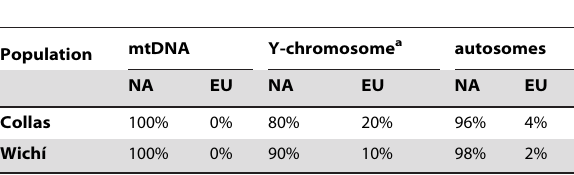
Table 2. European admixture proportions in the two study